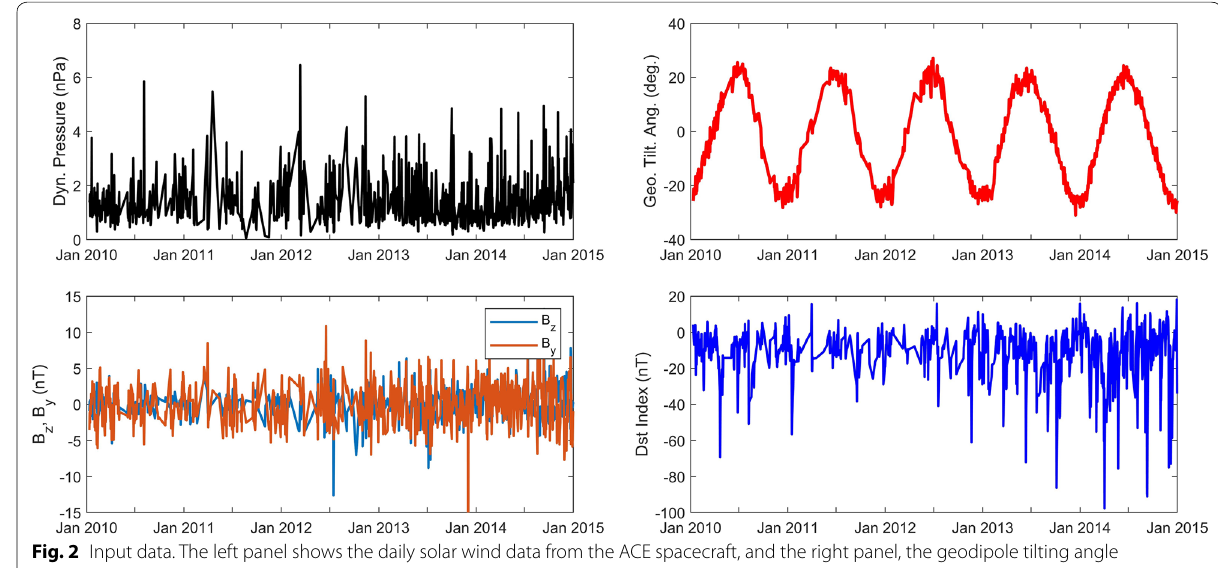
Fig. 2 Input data. The left panel shows the daily solar wind data from the ACE spacecraft, and the right panel, the geodipole tilting angle (computed by the GEOPACK package subroutines), with the Dst index profile from 2010 to 2014